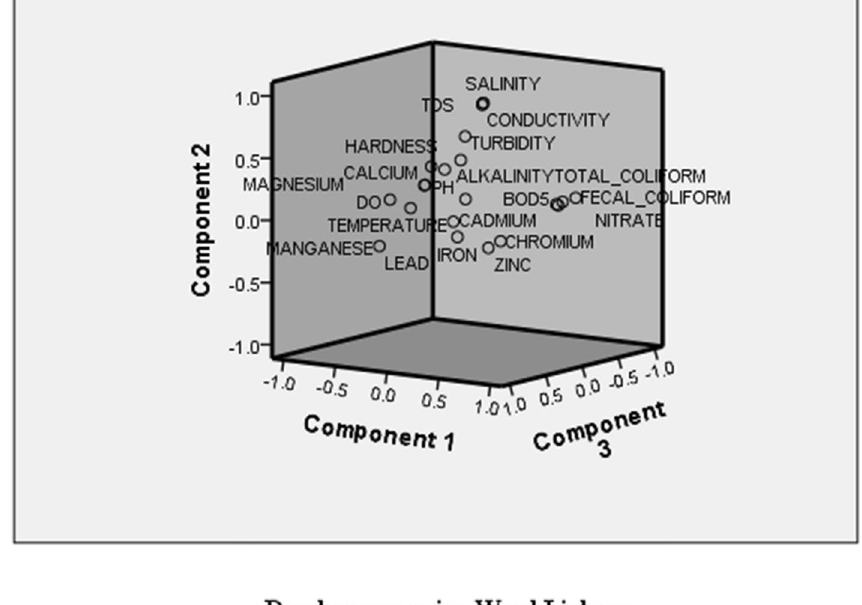
Fig. 3 Dendrogram for cluster analysis of 16 boreholes in okobo using ward’s method, square Euclidean